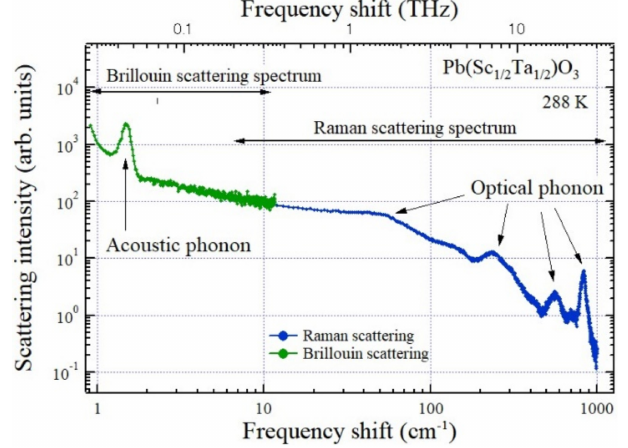
Figure 3. Broadband inelastic light scattering spectrum of a ferroelectric Pb(Sc 1/2 Ta 1/2 )O 3 crystal. Brillouin and Raman scattering spectra were measured by a tandem multi-pass FPI and triple-grating spectrometer, respectively